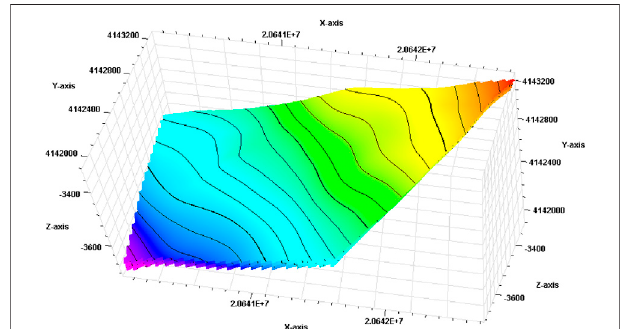
FIGURE 7 | The structural model of the Wang 587 Block.